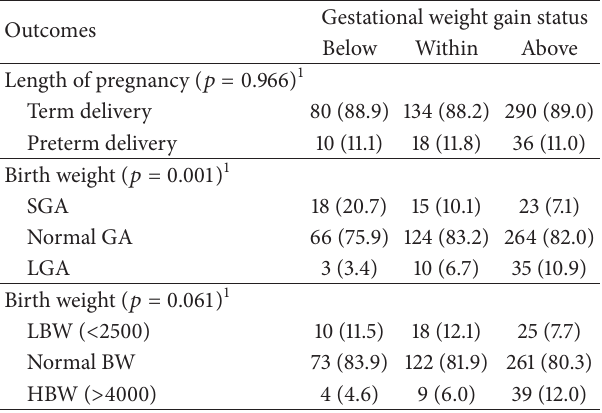
Table 4: Prevalence of selected pregnancy outcomes by gestational weight status in overall study sample ( 𝑁 = 571